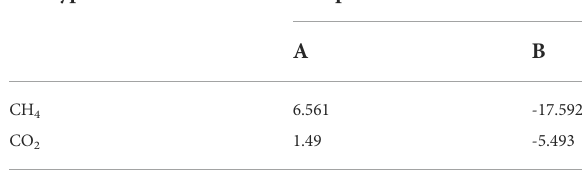
TABLE 2 Strain-temperature fi tting constants of coal samples for different adsorbed